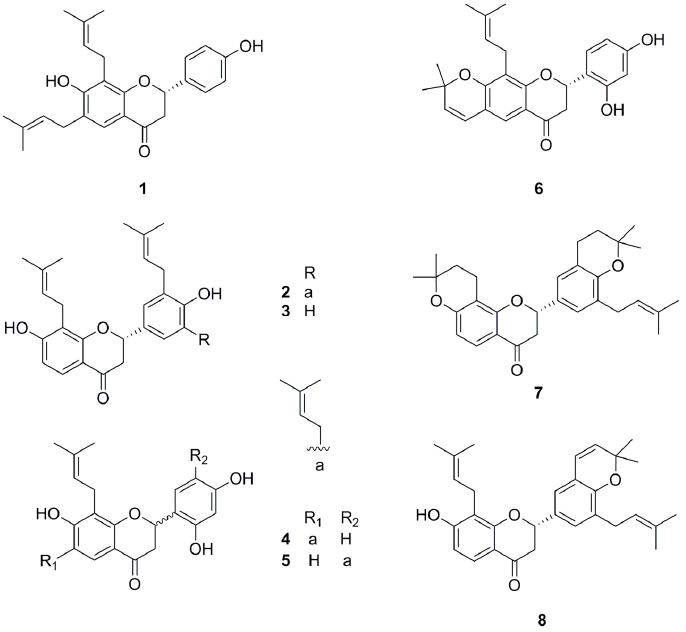
Figure 1. Chemical structures of compounds isolated from S. tonkinensis .